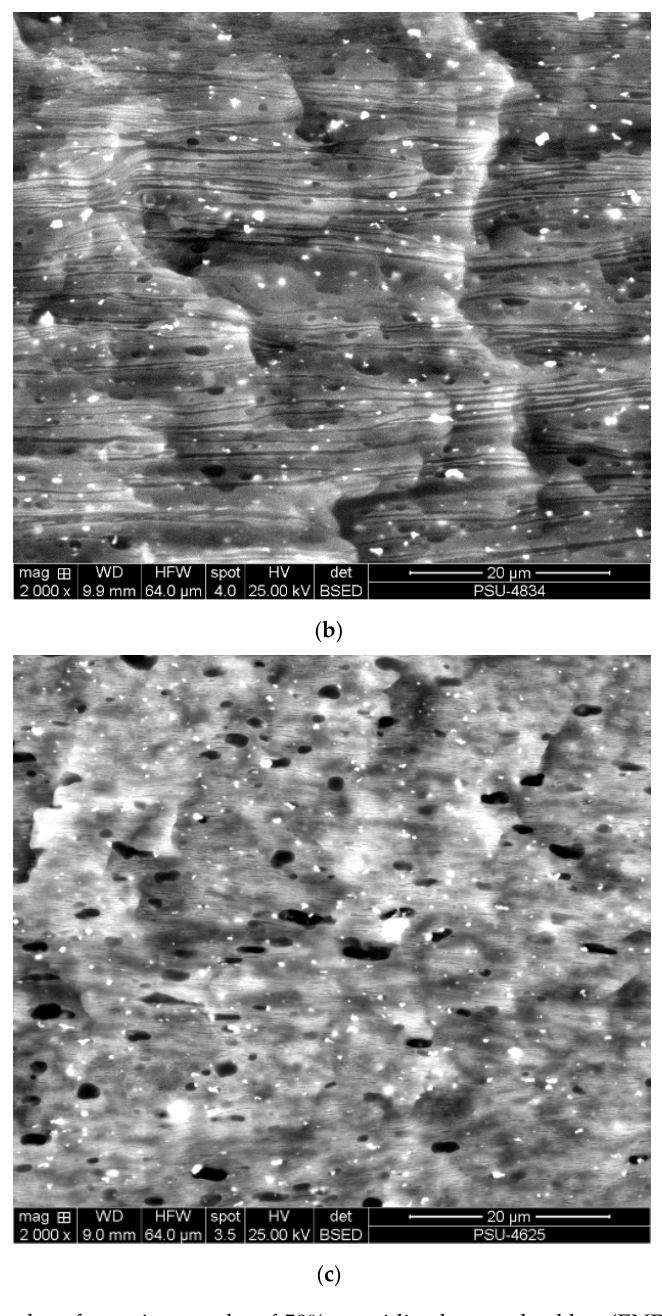
Figure 2. Fractured surface micrographs of 50% epoxidized natural rubber (ENR-50)/PCL blends: ( a ) ENR-50/PCL 25/75, ( b ) ENR-50/PCL 50/50, and ( c ) ENR-50/PCL 75/25.